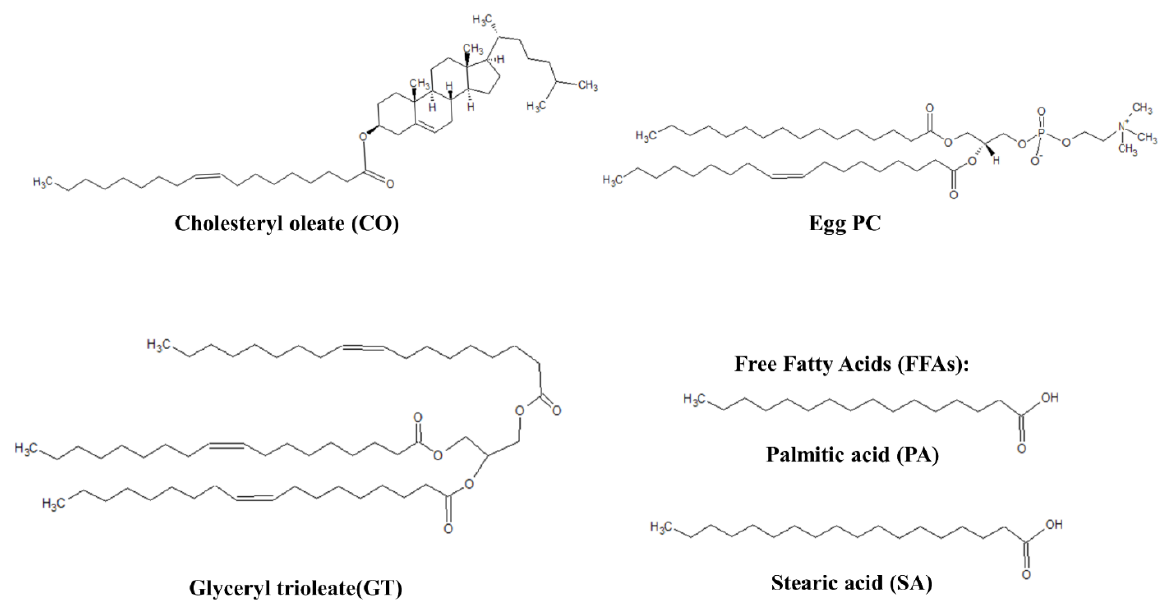
Figure 1. Representative lipids of TFLL model membranes.